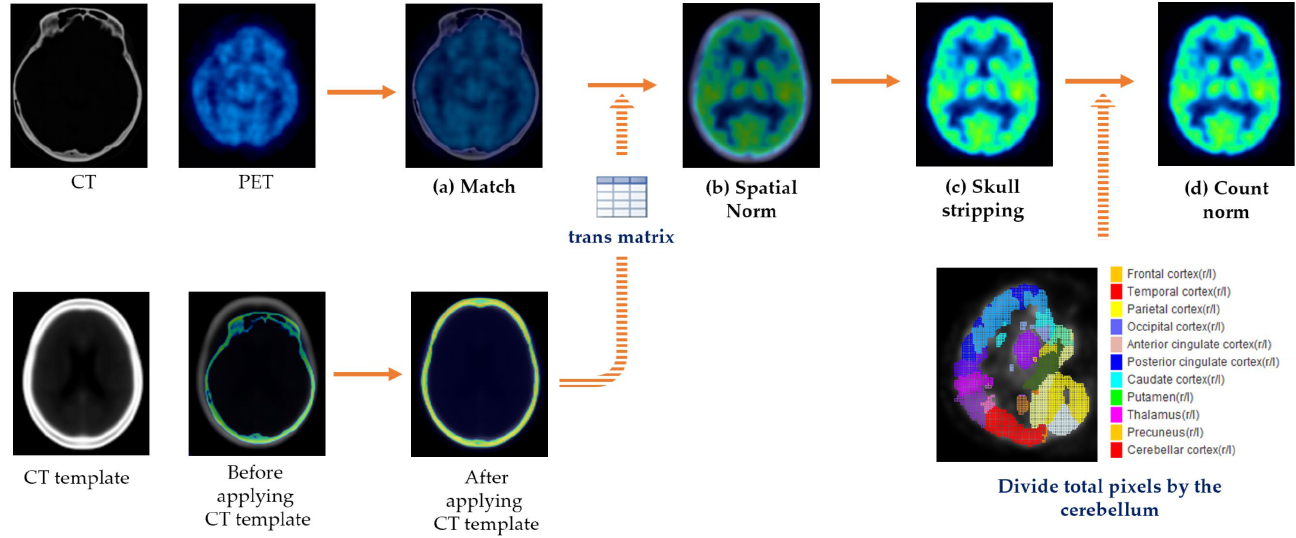
Figure 2. Data preprocessing. ( a ) Match: match CT and PET images into one; ( b ) Spatial Norm: spatial normalization. With the matrix information obtained by matching the CT to the CT template, the shape of the PET is also matched to the CT template; ( c ) Skull stripping: Remove the skull from the matched image; ( d ) Count norm: count normalization. Divide the total pixels by the cerebellum value.